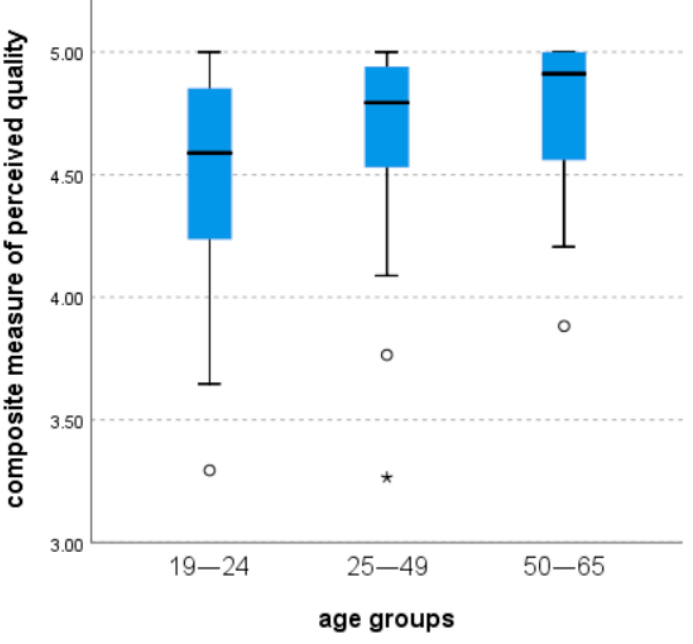
Figure 4. Comparison of item means per age groups of users.